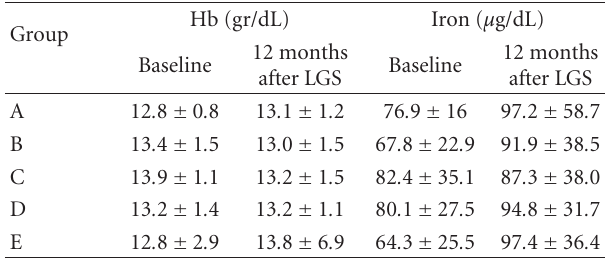
Table 3: Haemoglobin (Hb) and iron before and after surgery.